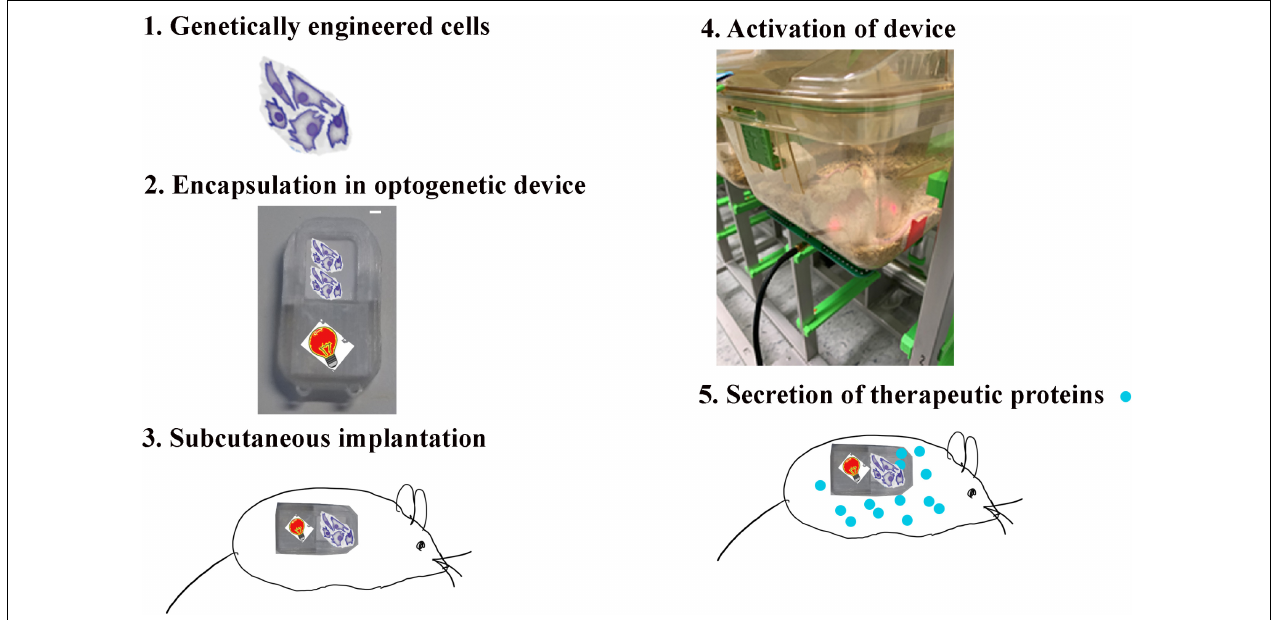
FIGURE 1 | Method of the implantation of the wireless-powered cell-based device. The implantation of the wireless-powered cell-based device [18 × 34 × 3 mm (L × l × H)] in the mouse requires that genetically engineered cells be able to secrete the protein of interest and activate the wireless-powered optogenetic implant. The cells (1) are loaded in the device (2), and the device is implanted in the mouse (3). After complete wound healing, the wireless-powered optogenetic device is activated (4) to secrete the protein of interest in the body of the animal